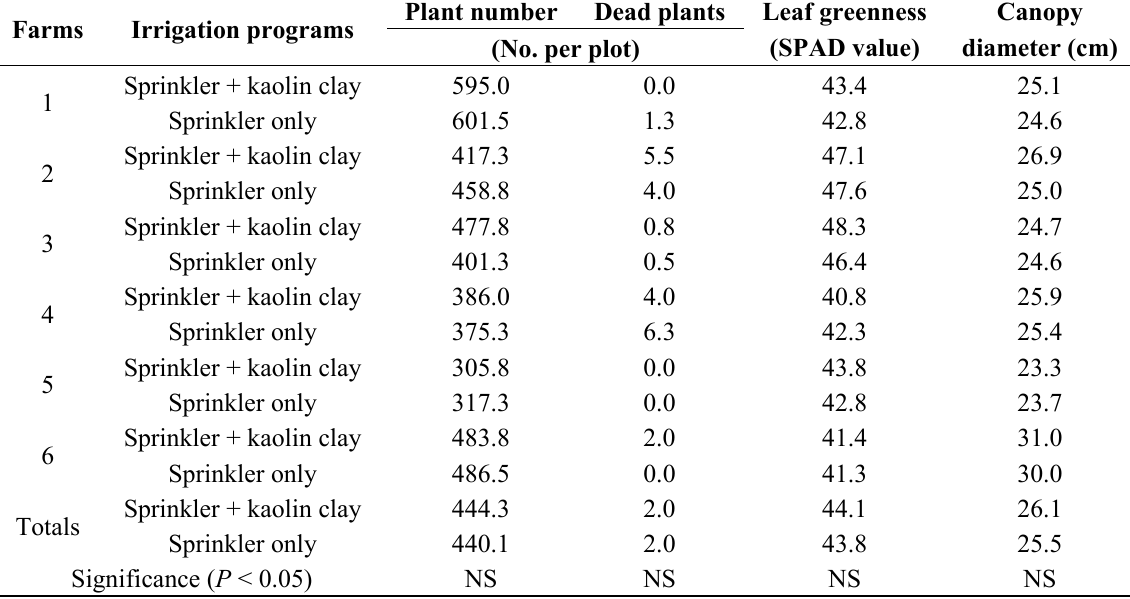
Table 4. Effects of irrigation programs in growers fields (6.4 ha) for strawberry transplant establishment on plant number, leaf greenness and canopy diameter between two and three weeks after transplanting in the Plant City-Dover area, FL, USA, during the 2011–2012 season. Establishment practices were 10 days of sprinkler irrigation and seven days of sprinkler irrigation plus kaolin clay on the eighth day. NS = non-significant at P < 0.05. Plant number Dead plants Leaf greenness Canopy Farms Irrigation programs (SPAD value) diameter (cm)(No. per plot) Sprinkler + kaolin clay